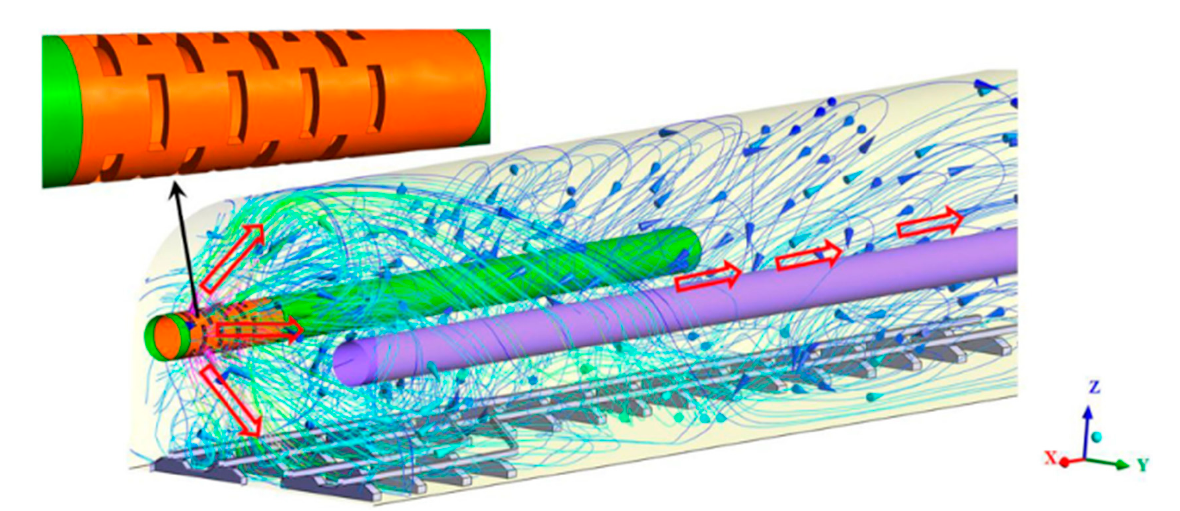
Figure 10. A schematic diagram of the velocity streamlines of the 3D spiral wind-curtain [76]. (Adapted with permission from ref. [76]. Copyright 2020 Elsevier Ltd.).